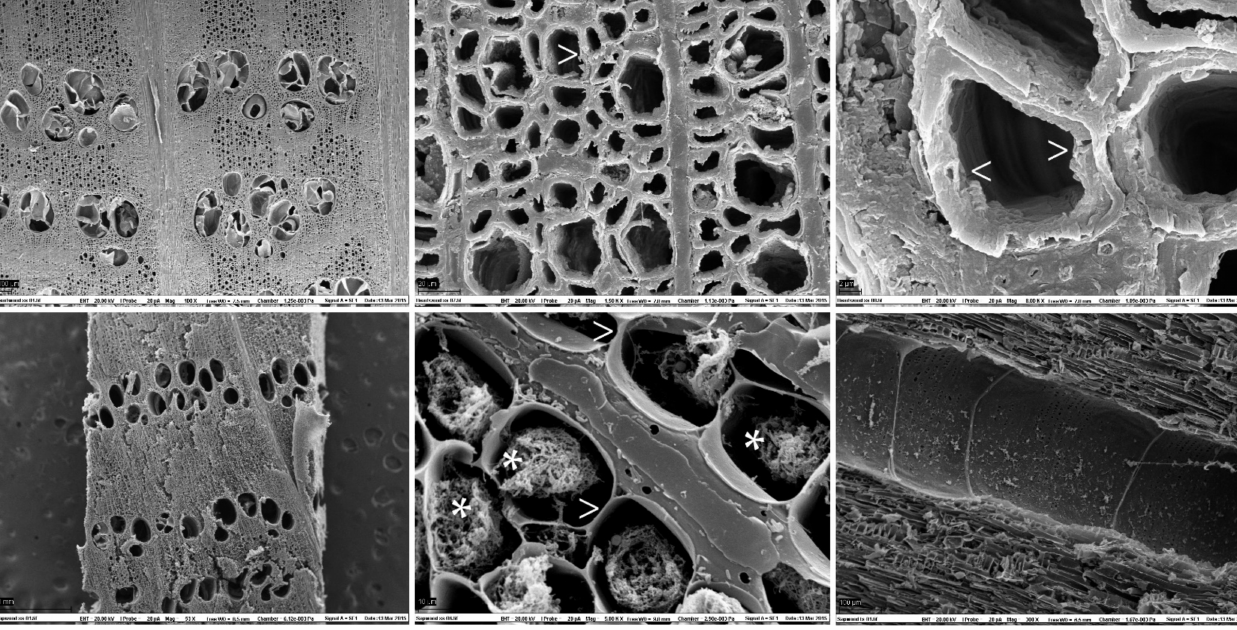
Figure 2. SEM images (Carl Zeiss AG-EVO ® 50 scanning electron microscope using a cryo-SEM technique) of waterlogged oak excavated from the Lednica Lake; upper row—better-preserved heartwood (loss of wood substance about 10–20%) with thick cell walls (arrows) still consisting of all their layers (however sometimes partially degraded or detached); lower row—highly degraded sapwood (loss of wood substance about 70–80%) with a residue of the degraded secondary cell walls visible inside cell lumina (asterisks) and much thinner cell walls consisting mainly of the middle lamella